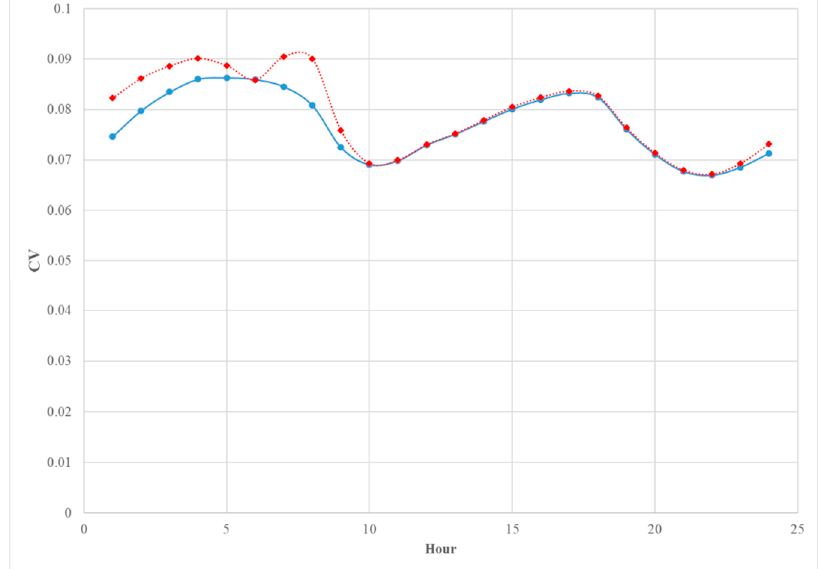
Figure 10. The comparison between the CV of the predicted hourly average load of Model 1 (blue solid) and Model 2 (red doted).